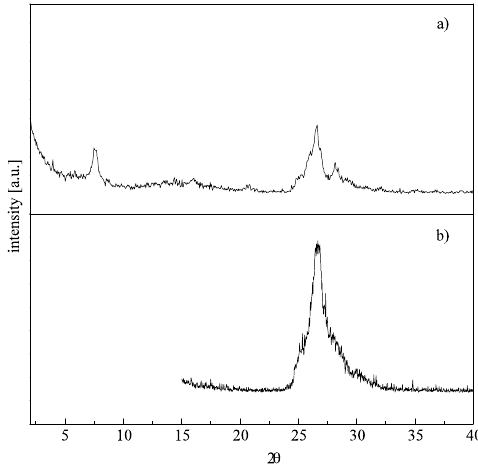
Figure 4. XRD patterns of the γ -TiPCdS (a) and CdS